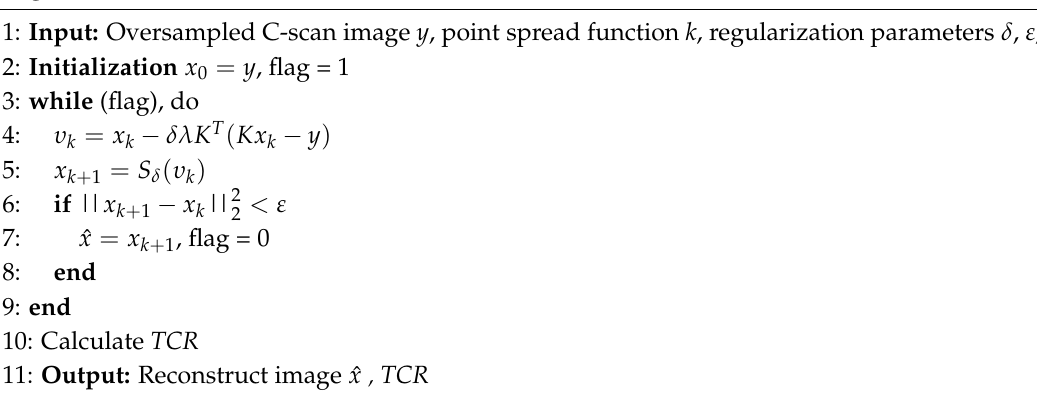
Algorithm 1. Pseudocode of